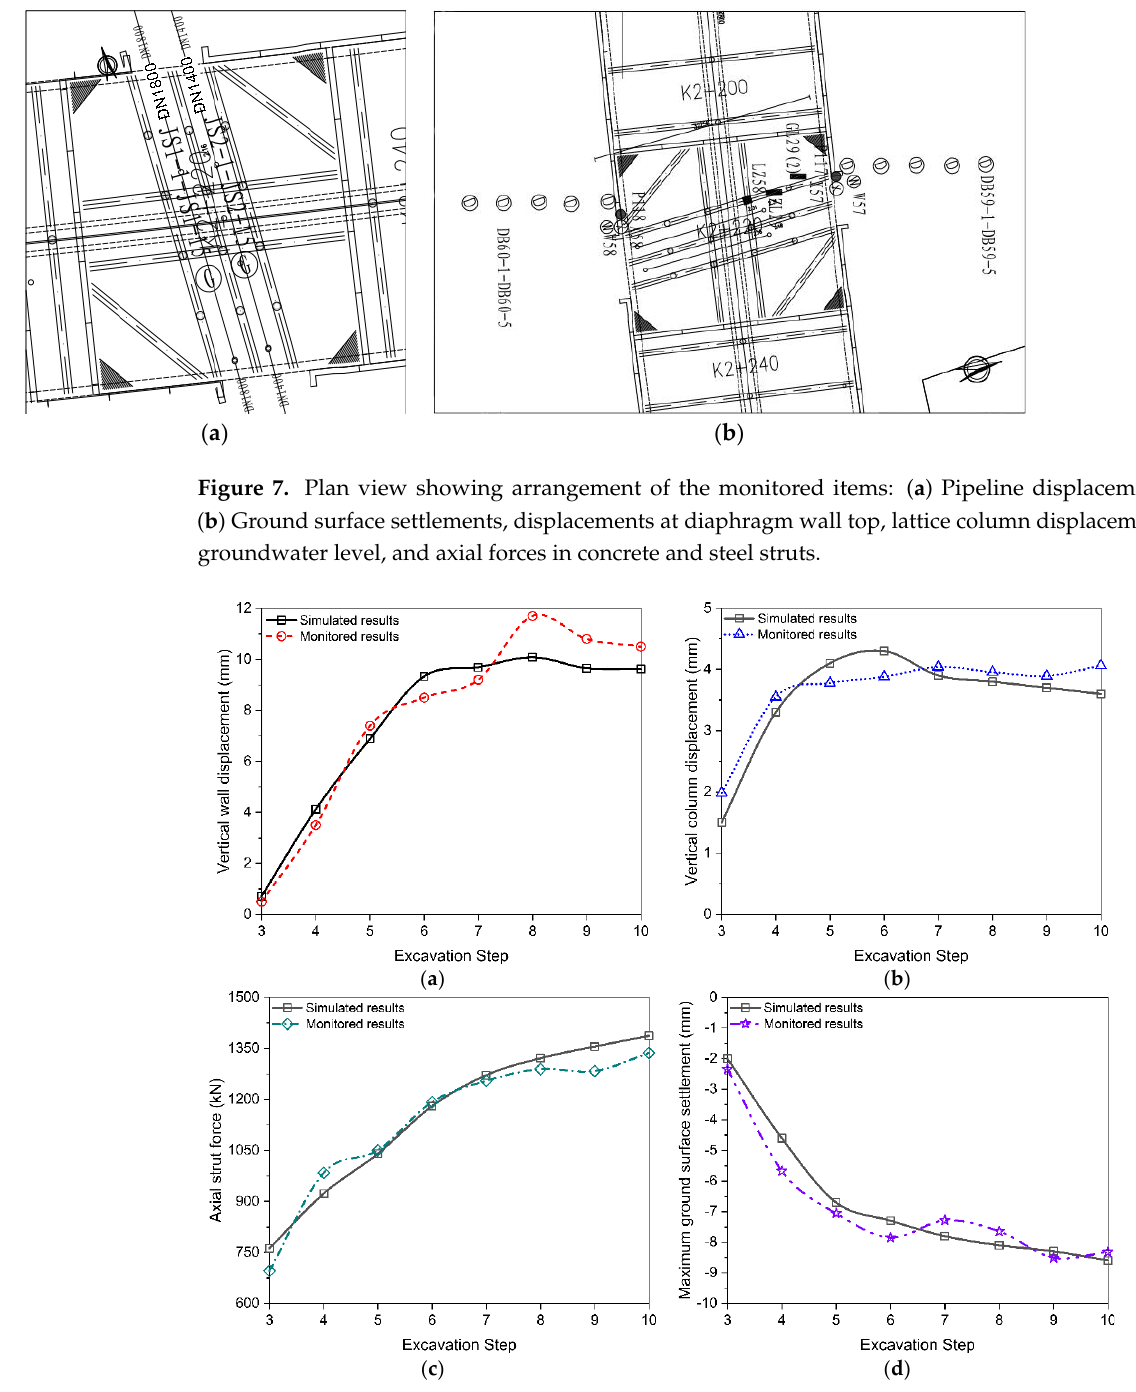
Figure 8. Comparison of simulated results by the finite element method and monitored results in terms of ( a ) Vertical wall displacement at P117; ( b ) Vertical column displacement at LZ58; ( c ) Axial strut force at ZL29; ( d ) Maximum ground surface settlement along DB59-1 – DB59-5.